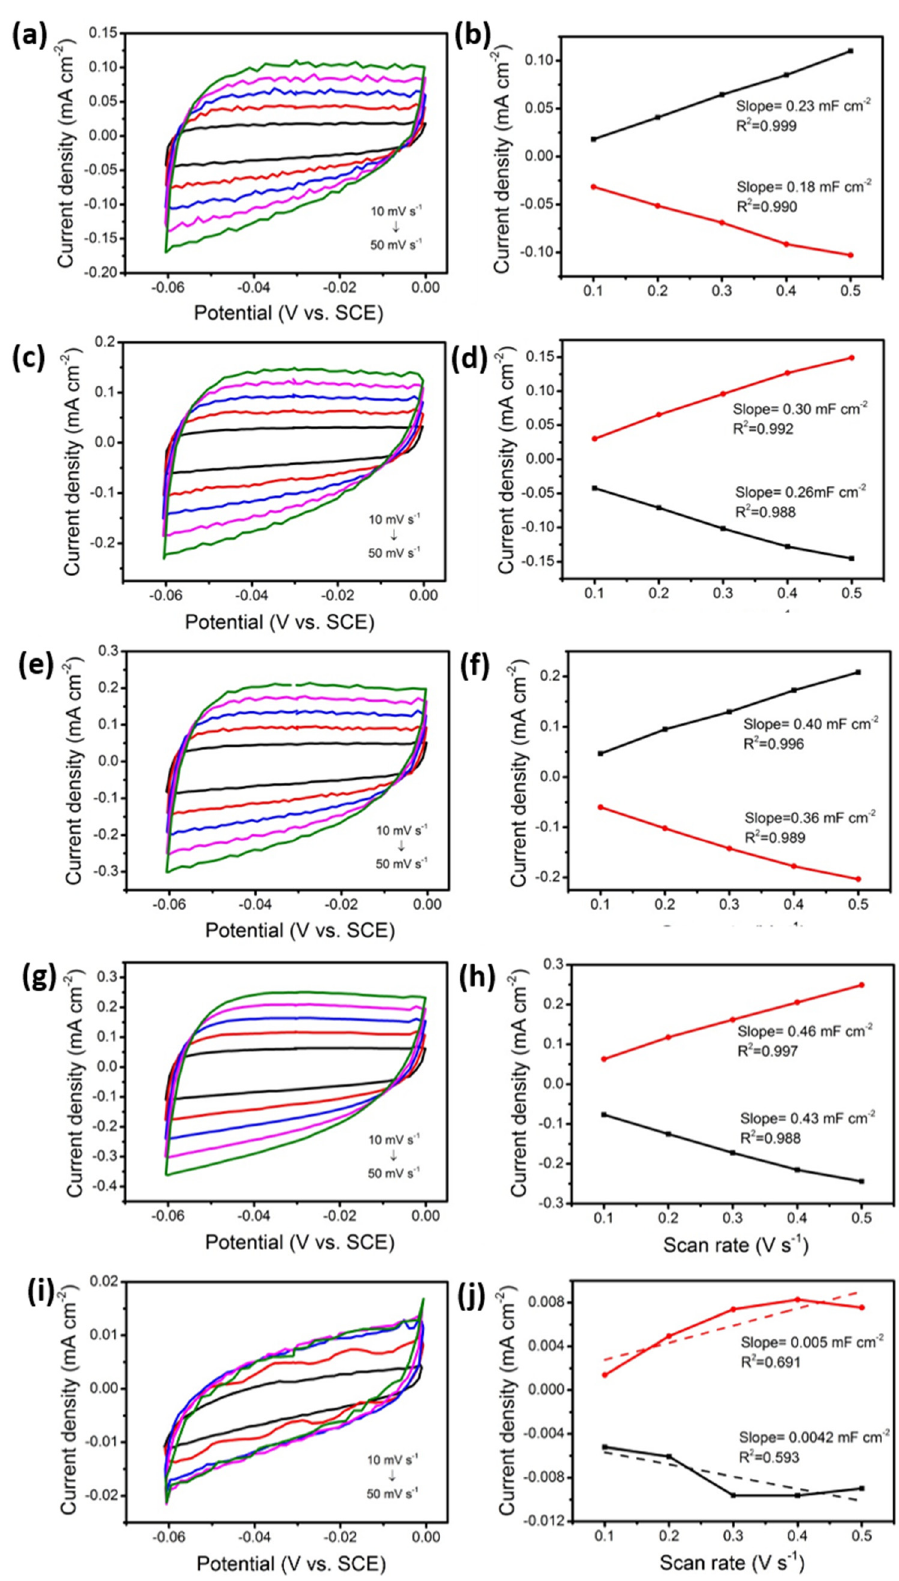
Figure 4. CV curves in non-Faradaic region and the ratio of cathodic/anodic current with various scan rates of ( a , b ) α -Fe 2 O 3 @CC, ( c , d ) Ba-Fe 2 O 3 @CC, ( e , f ) Mg-Fe 2 O 3 @CC, ( g , h ) Sr-Fe 2 O 3 @CC, and ( i , j ) Ca-Fe 2 O 3 @CC.